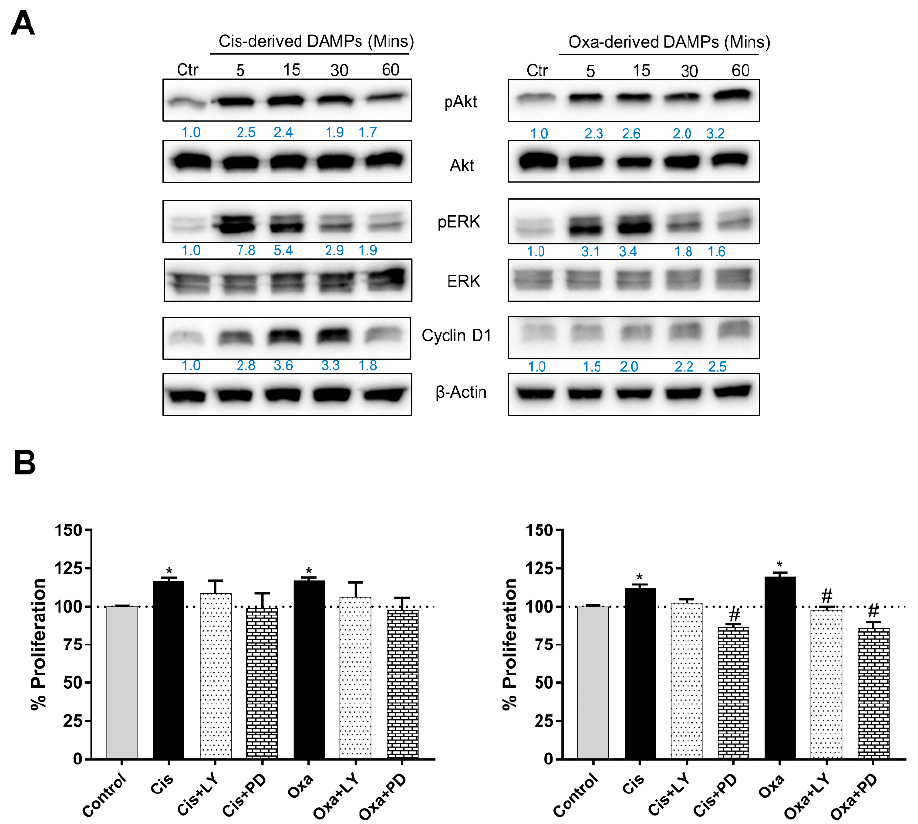
Figure 5. Cisplatin- and oxaliplatin-derived DAMPs induced CCA proliferation mediated pro-survival signaling. ( A ) KKU213L5 and KKU100 cells were incubated with conditioned media as indicated times, and survival associated signaling proteins were determined using immunoblotting. β - actin was used as loading control. ( B ) For phenotypic confirm, additional of 15 µM of LY294002 or PD98059 were rechallenged with proliferation activity of DAMPs’ conditioned media. Cell viability was measured and quantified as %proliferation. * p < 0.05 compared with control treatment, # p < 0.05 compared with cisplatin- and oxaliplatin-derived DAMPs treatments.